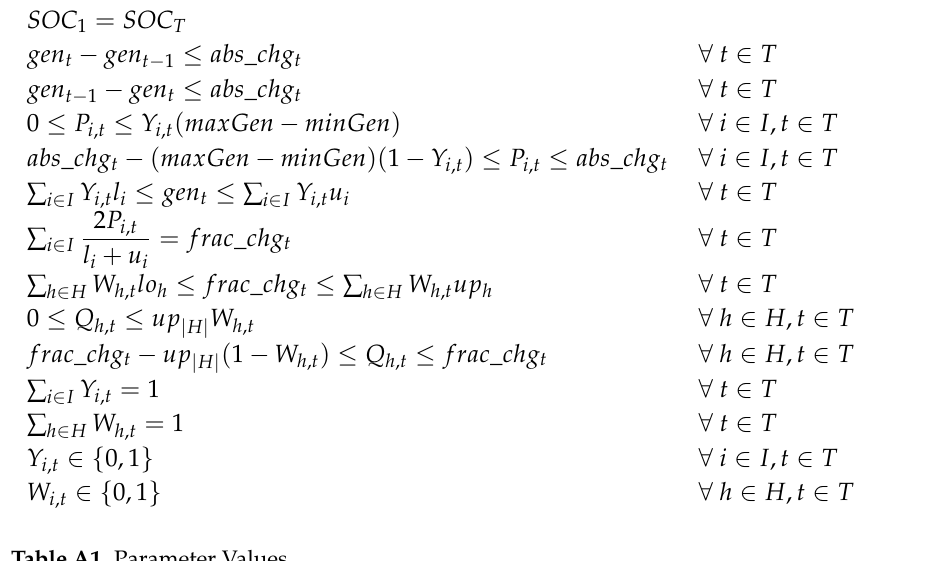
Table A1. Parameter